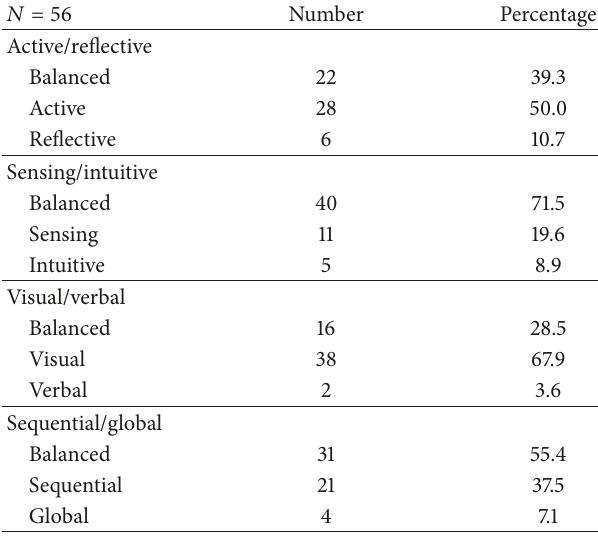
Table 2: The distribution of learning